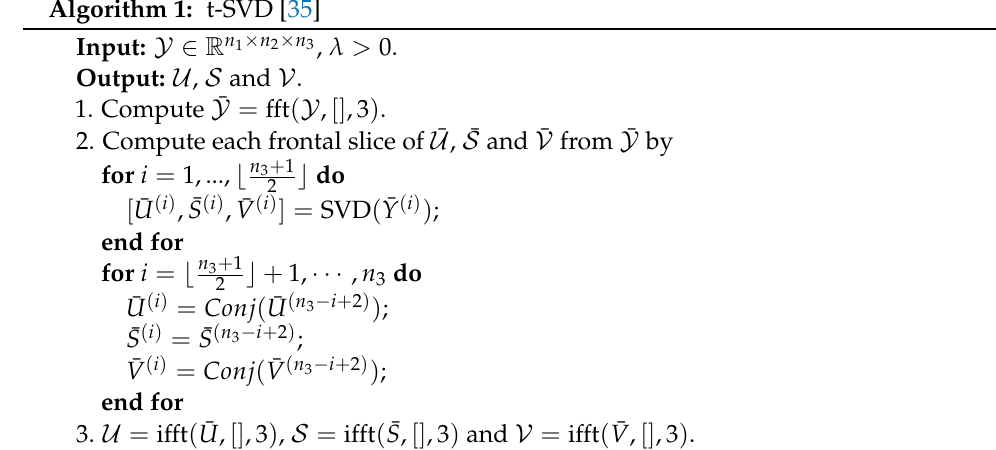
Algorithm 1: t-SVD